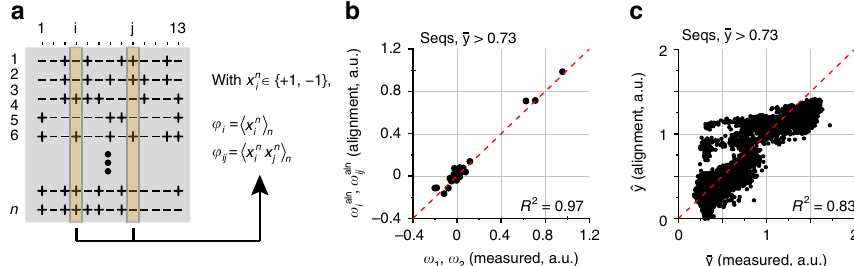
Fig. 5 Practical strategies for learning the epistatic structure: sequence statistics. a A representation of a multiple sequence alignment (MSA) x n i comprising n functional sequences (de fi ned as those with y > 0.73) by the i = (1 … 13) mutated positions; amino acids are represented by + 1 and − 1 to indicate residues in mTagBFP2 or mKate2, respectively. From the MSA, we can compute the average value of each position ( φ i ¼ x n i D E positions ( φ ij ¼ x n i x n j ). From these we calculate alignment epistatic terms ω aln i and ω aln ij as indicated in the “ Methods ” . b , c Estimation of measured fi n